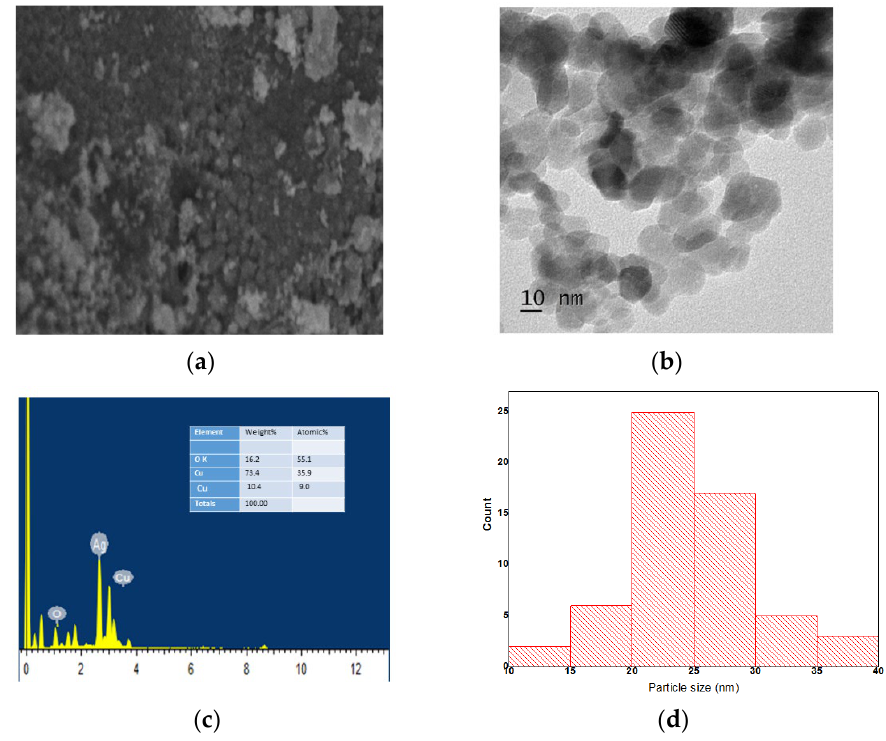
Figure 8. Images of SEM ( a ), TEM ( b ), and EDS ( c ) and the particle size histogram ( d ) of Ag/Cu NPs.